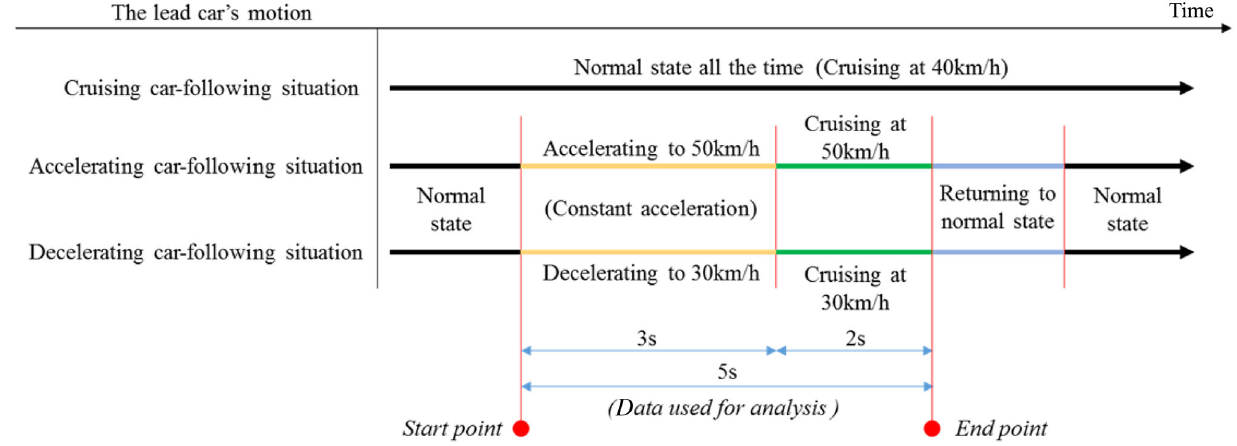
Fig. 4 Motion of the lead